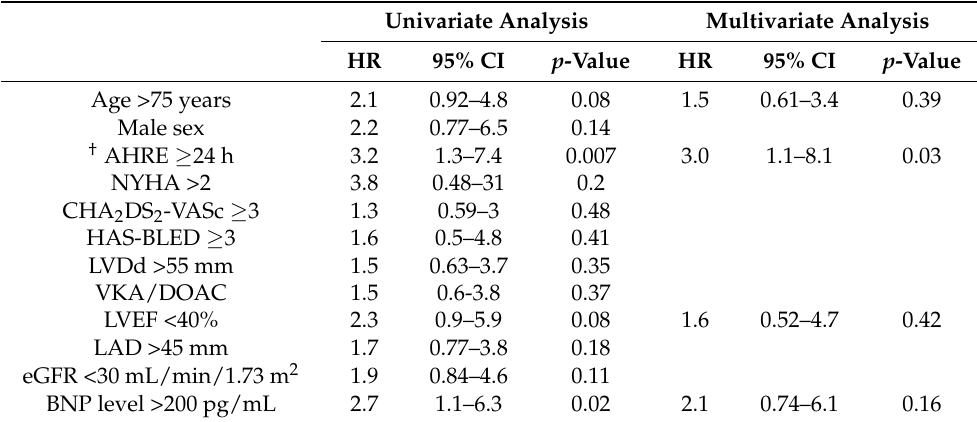
Table 4. Identification of predictive factors for MACEs in patients without a history of